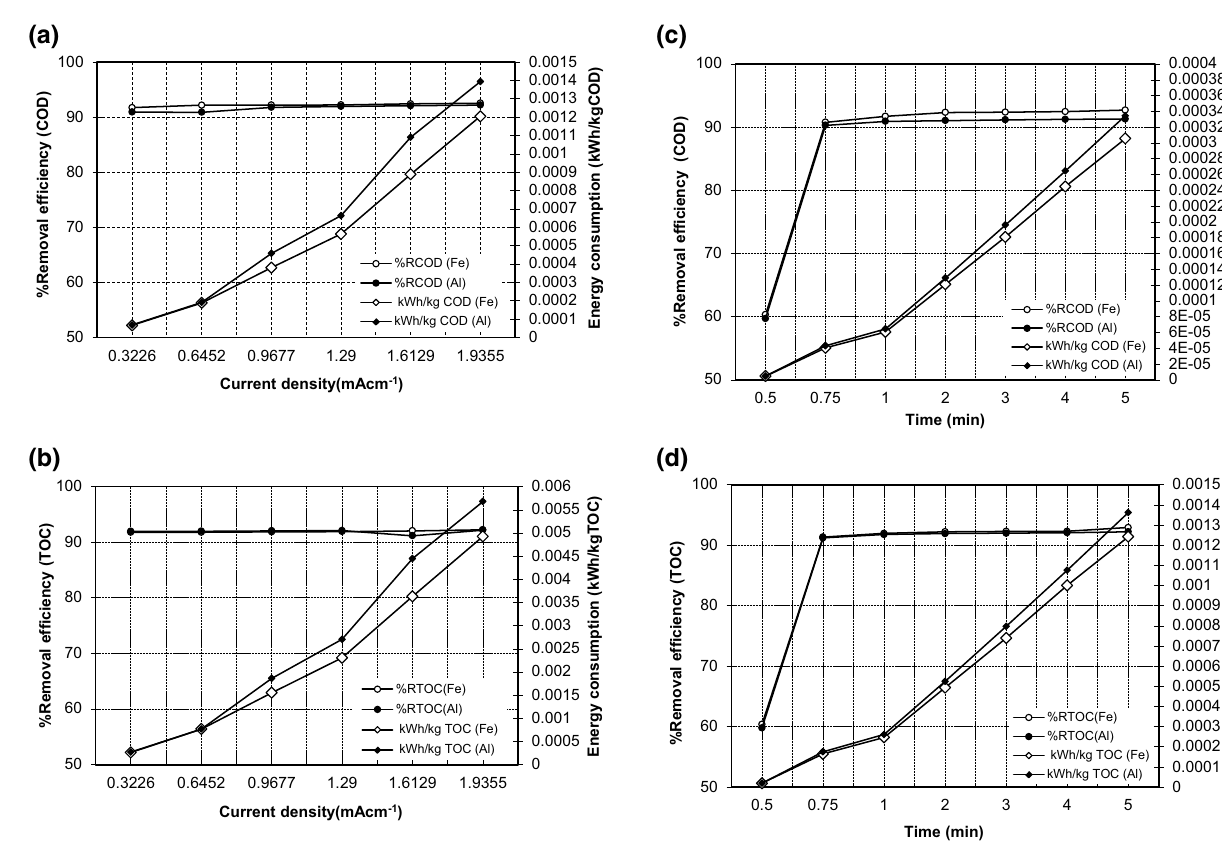
Fig. 6 Effect of current density ( a , b ) and electrolysis time ( c , d ) on the electric energy consumption and COD ad TOC removal efficiency ( i = 0.3226 mA/cm 2 ; C o,COD = 399,800 mg; C o,TOC = 98,120 mg/L;